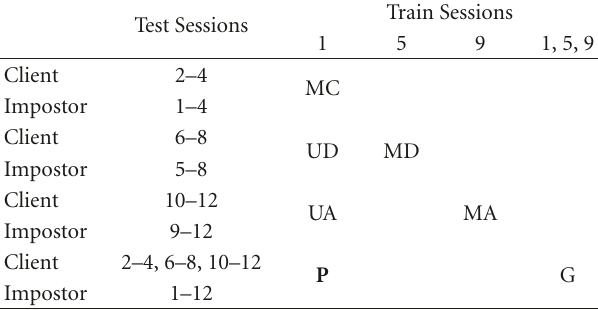
Table 1: Summary of the 7 training/testing configurations of